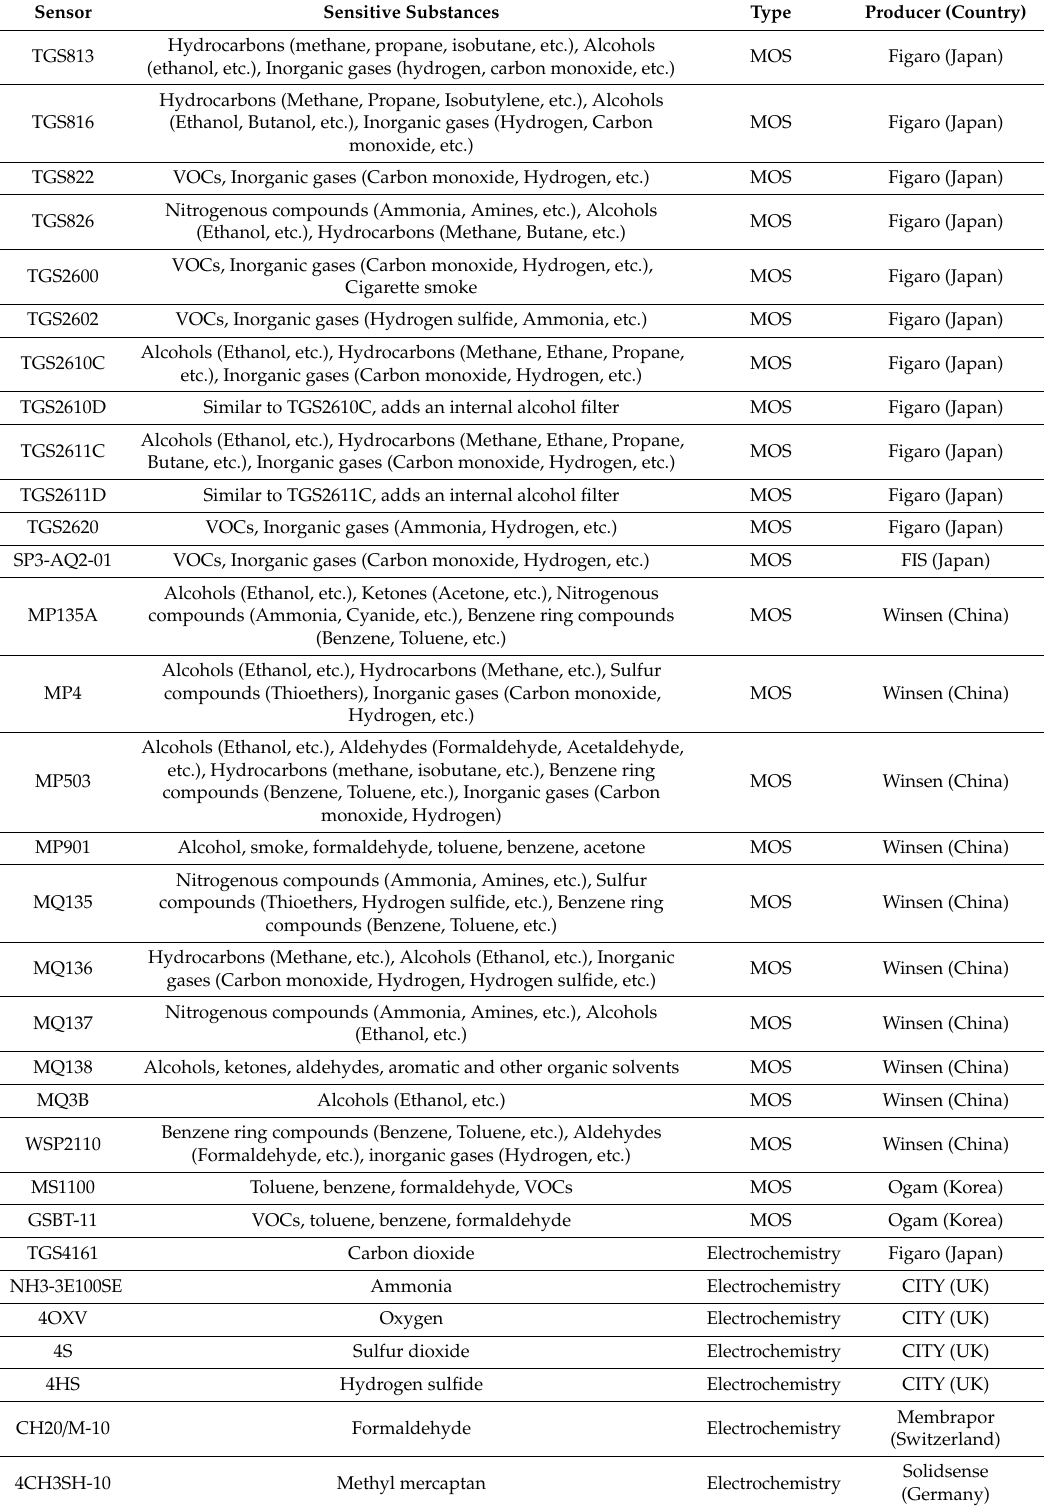
Table 1. Main information of gas sensors in sensor